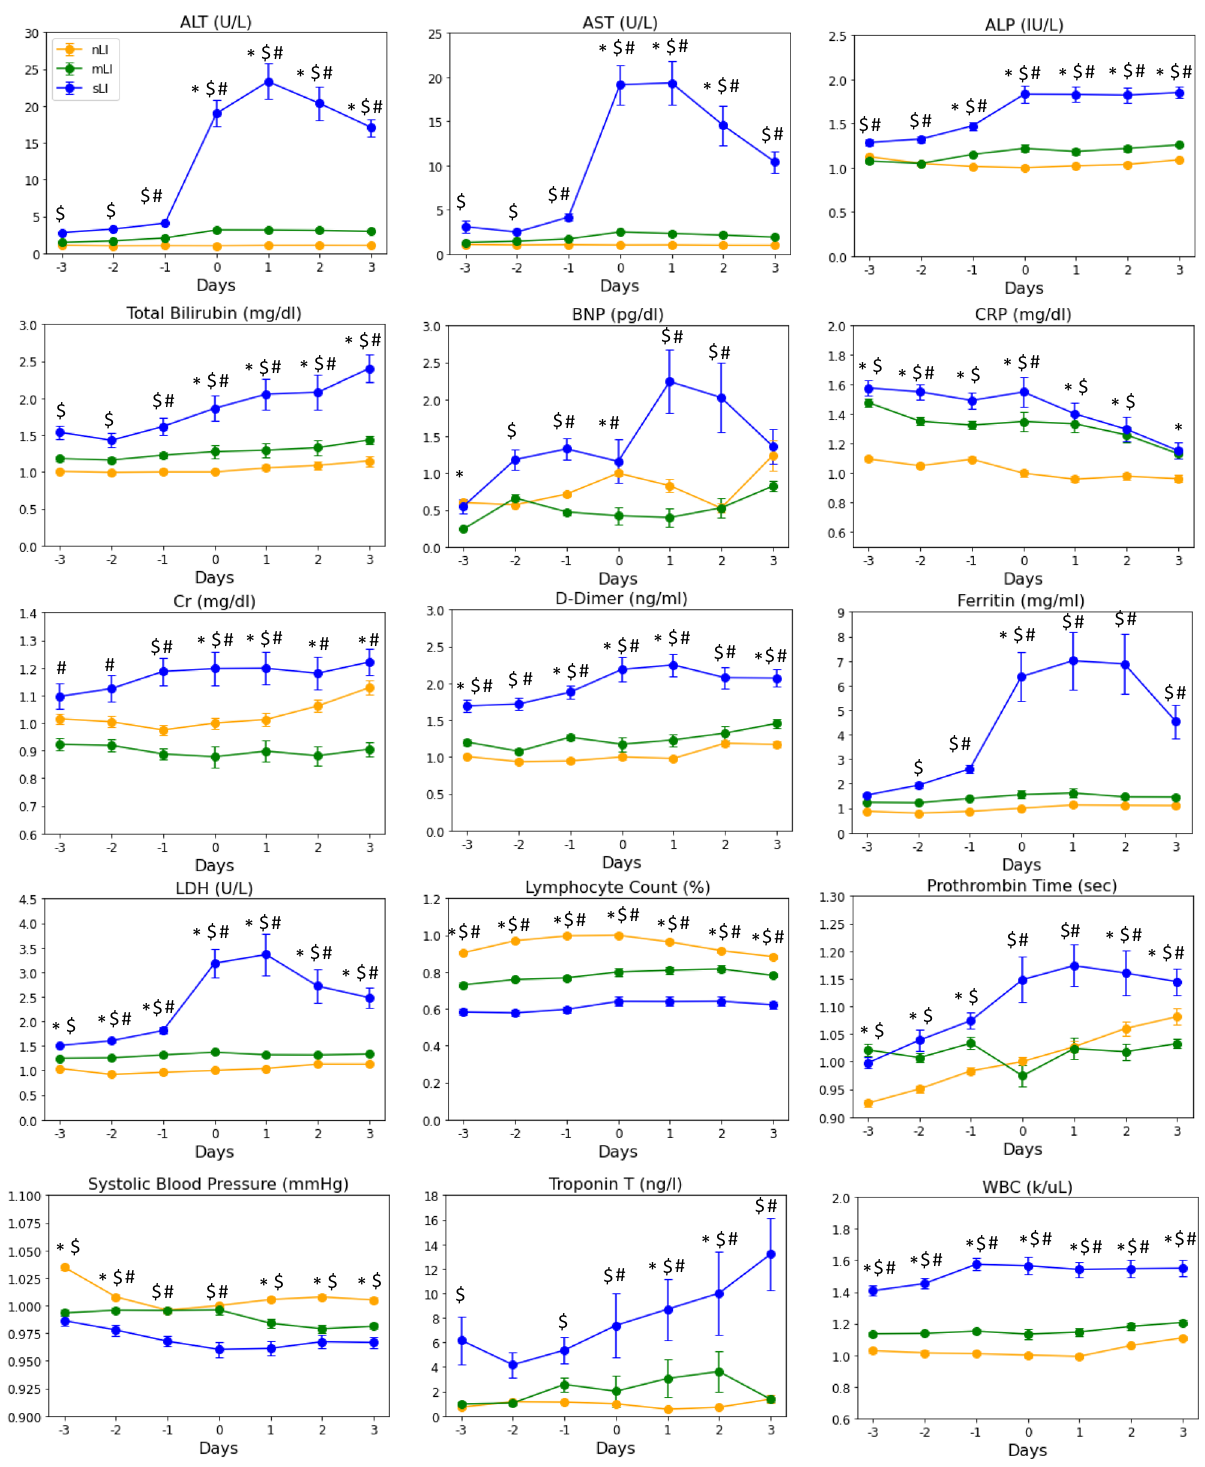
Figure 3. Temporal progression of laboratory tests, vitals and blood gases with time 0 representing day of liver injury onset in liver injury patients. No liver injury patient data was also centered around 3rd day after hospital admission. Values are normalized by dividing all data points by value of reading at time 0 of nLI group. BNP brain natriuretic peptide, ALT alanine aminotransferase, AST aspartate aminotransferase, LDH lactate dehydrogenase. No liver injury (nLI) is the orange line. mild liver injury (mLI) is the grey line, mild liver injury. Severe liver injury (sLI) is the blue line. Error bars are SEM. *Significant between nLI and mLI, $ significant between nLI and sLI, and # significant between mLI and sLI based on linear mixed